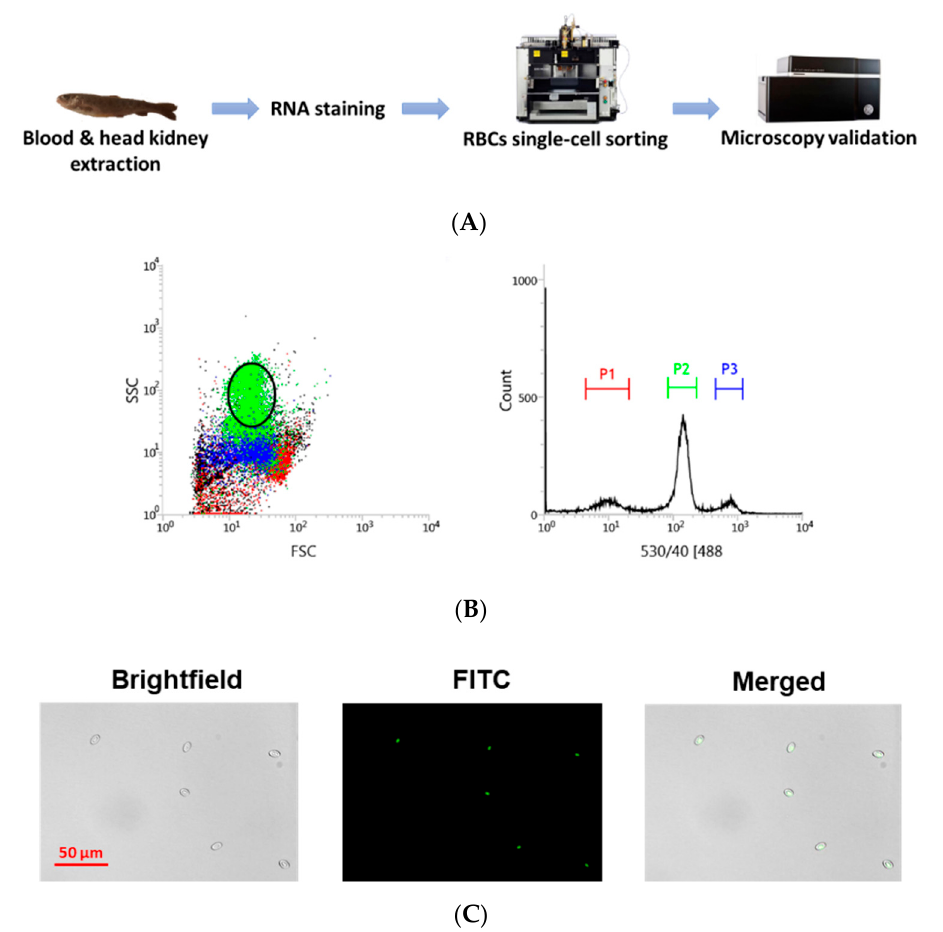
Figure 1. Overview of the single-cell sorting methodology. ( A ) Workflow of single-cell sorting using the BD FACSJazz cell sorter. ( B ) Double gating population selection for RBCs sorting based on: (i) Fluorescence intensity, where the P2 (green) population corresponds to RBCs, and a (ii) forward-scattering (FSC)/side-scattering (SSC) dot plot, where the selected circled population corresponds to RBCs. ( C ) Representative bright-field and fluorescein (FITC) microscopy images of single-cell sorted RBCs from the head kidney (HK), taken with 10× magnification.